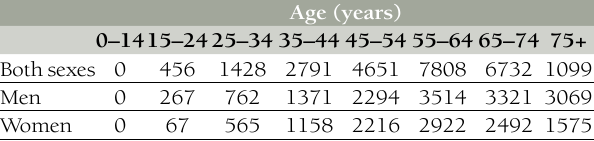
Figure 7 Crude incidence of colorectal cancer by age group for both sexes ( A ), men ( B ) and women ( C ).